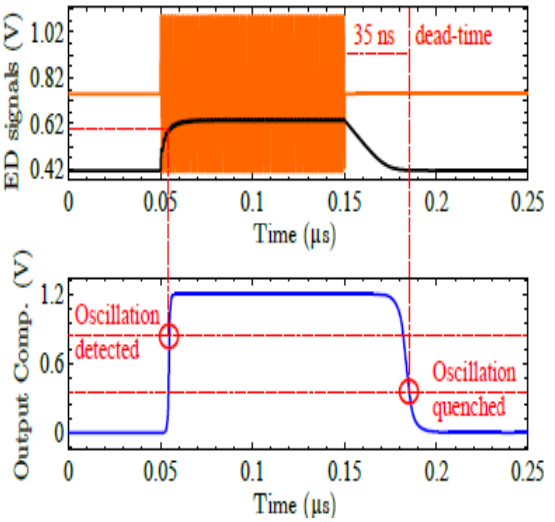
Figure 10 . Transient behavior of the envelope detector and the comparator for ideal oscillator input .